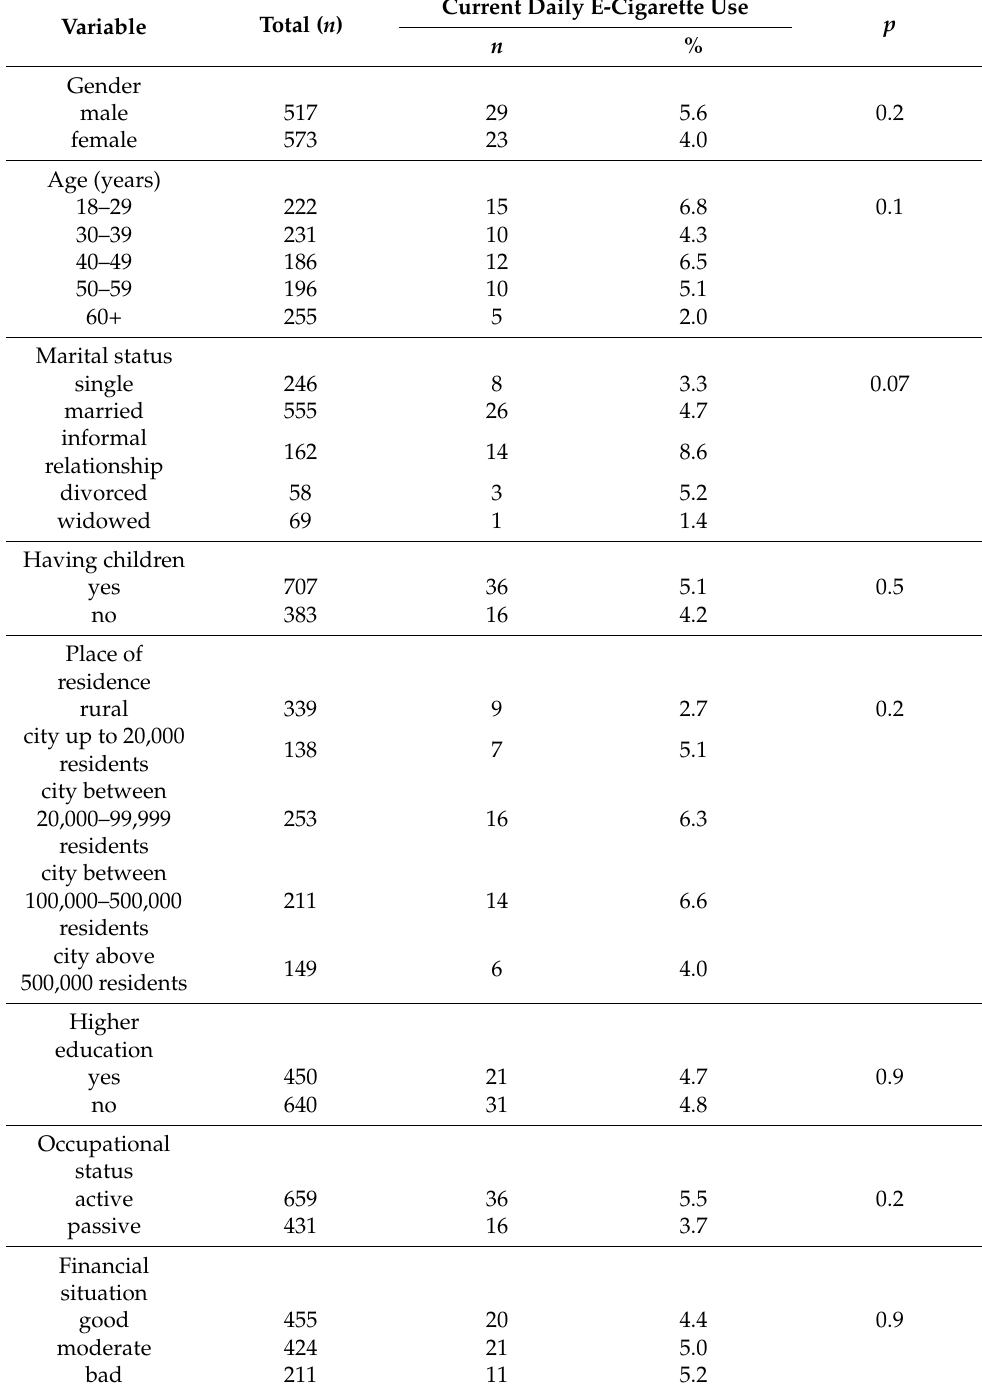
Table 4. The prevalence of e-cigarette use among adults in Poland, n =